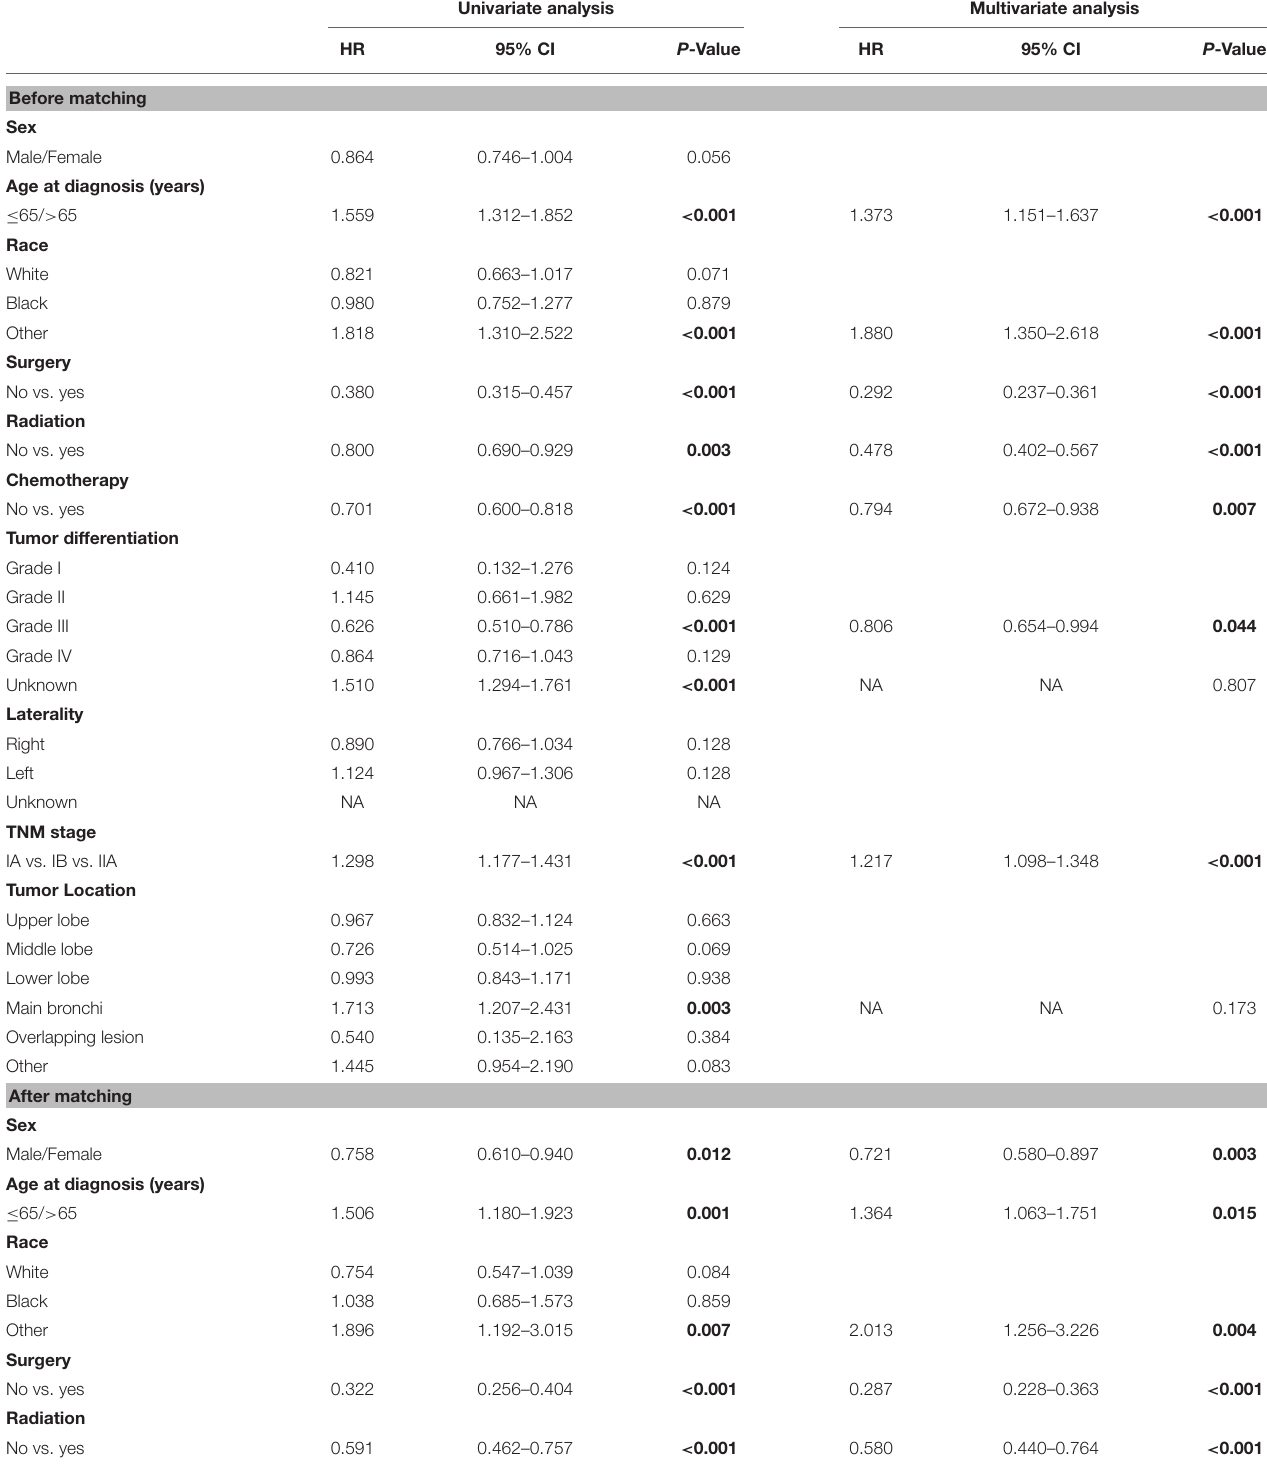
TABLE 3 | Univariate and multivariate Cox regression analysis for cancer-specific survival in patients with stage I-IIA SCLC cancer (Cox regression’s method is Forward: LR). Univariate analysis Multivariate